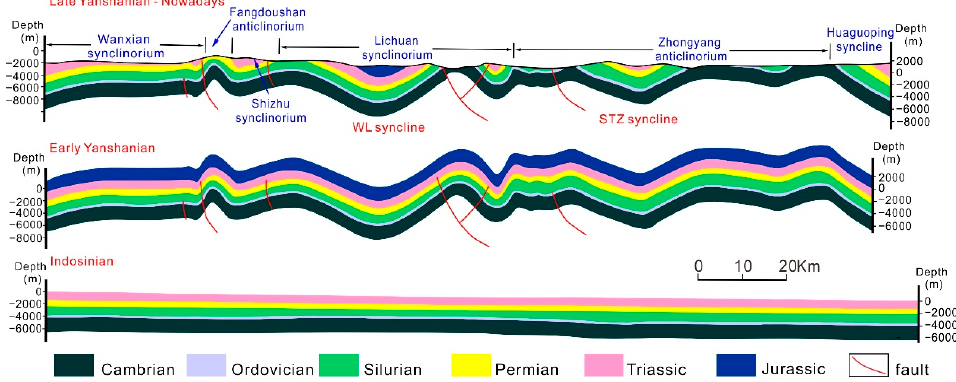
Figure 7. Overpressure–atmospheric tectonic evolution section in southeast Chongqing.